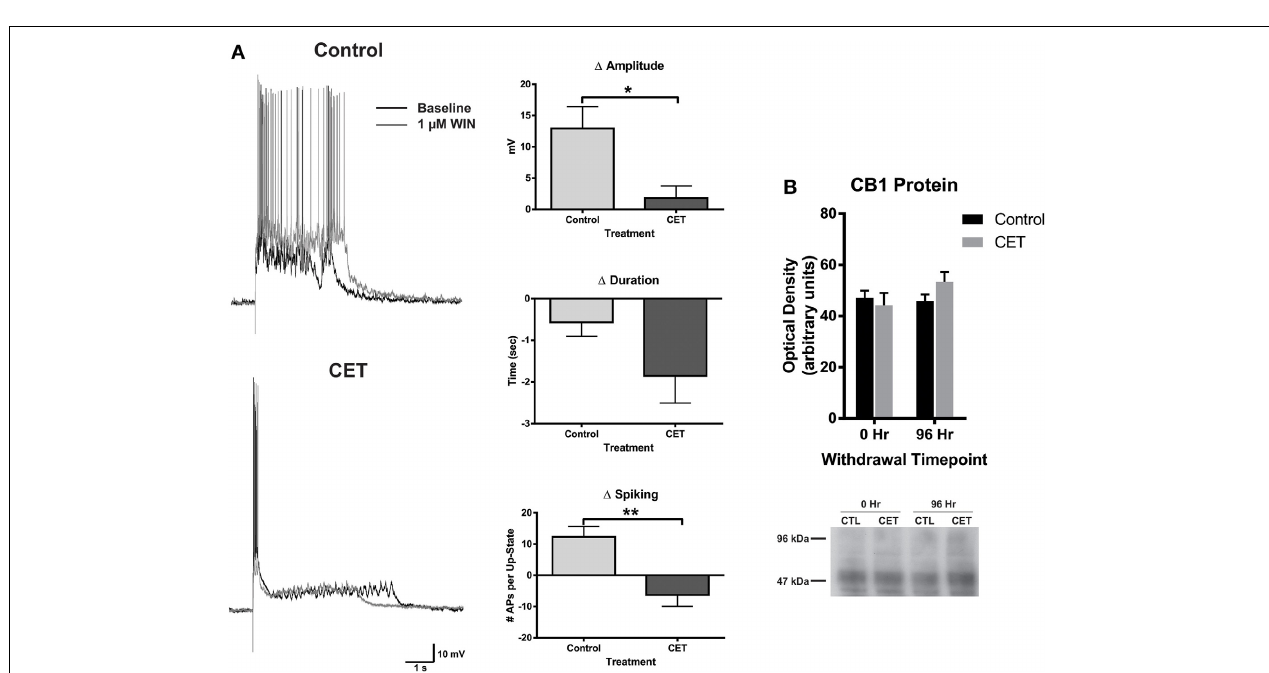
EtOH culture. Graphs show summary data of baseline measures of up-state parameters in control and CET culture ( N = 23–26). Horizontal lines represent group means. Asterisks represent significant group differences ( p < 0 . 05).